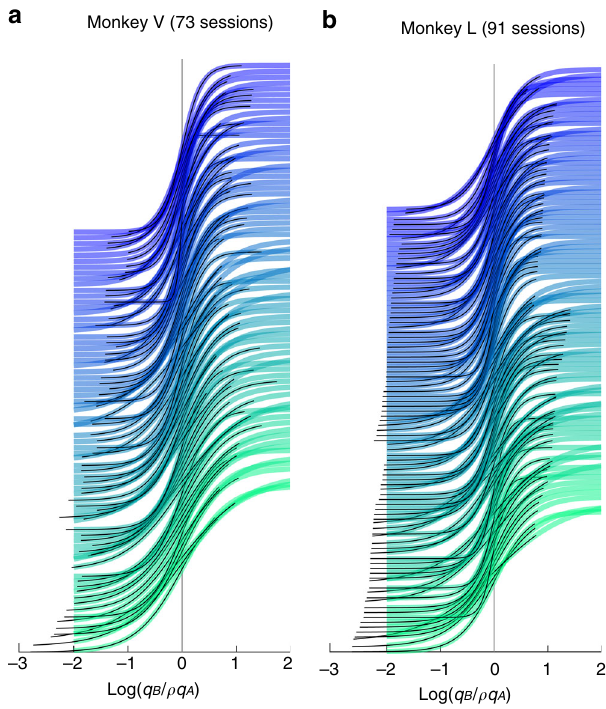
Fig. 5 Relation between sigmoid steepness and value range. a Monkey V (73 sessions). For each session, the sigmoid fi t provided measures for ρ and η (Eq. 6), and we computed the geometric mean value range Δ . In this plot, different sigmoid functions are aligned at the fl ex ( x -axis) and ranked based on Δ , from top (small Δ ) to bottom (large Δ ). For each sigmoid, the thick colored line (blue-green) depicts the result of the fi t in a standard interval [ − 2 2]. The thin black line highlights the range of values actually used in the corresponding session. Different shades of color (from blue to green) indicate the ordinal ranking of sessions according to Δ . Notably, sigmoid functions at the bottom of the fi gure (larger Δ ) were shallower (lower η ). b Monkey L (91 sessions). Same format as in